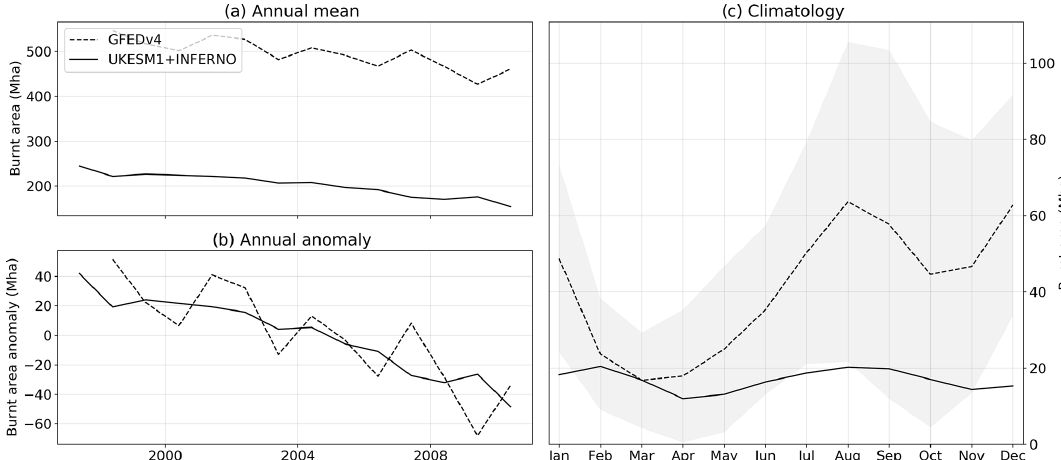
Figure 4. Burnt area annual mean time series (a, b) anomaly relative to climatology (Mha) and (c) burnt area fraction climatology (%) for UKESM1+INFERNO (solid line) and GFEDv4 (dashed line) with the shaded area representing the standard error around the GFEDv4